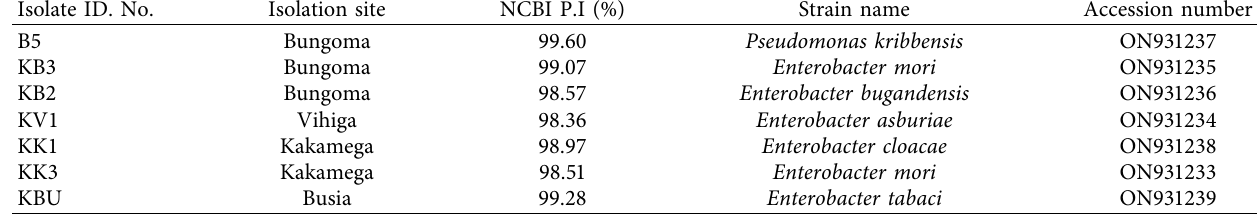
Table 2: Isolates and their related BLAST strains basing on partial sequencing of 16S ribosomal gene. Isolate ID. No.